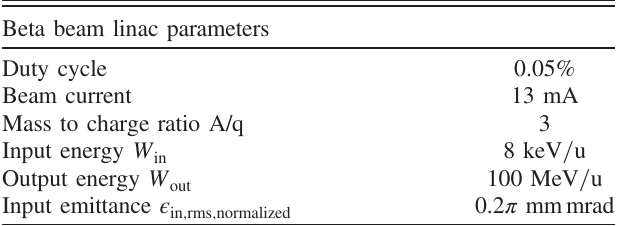
TABLE IV. Beta-beam requirements for the ion linac.